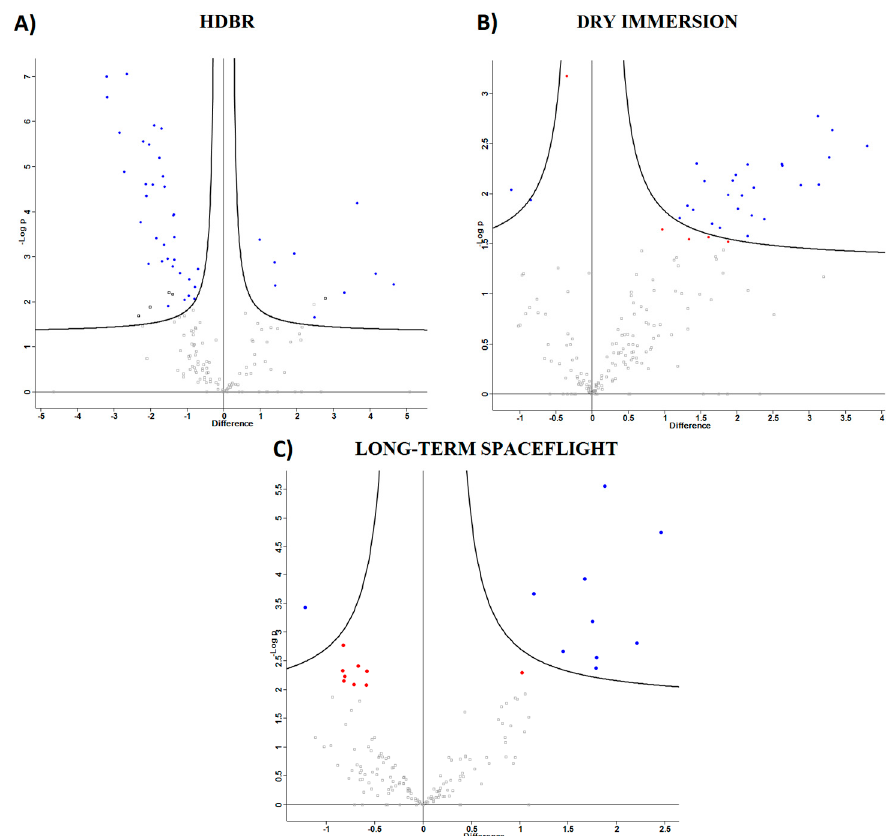
Figure 1. A volcano plot representing the results of the t -tests ( p -value > 0.01). The di ff erence for each protein was plotted against the –log10 of the p -value. ( A ) Proteins are significantly di ff erent from the background during head-down bed rest (HDBR). ( B ) Proteins significantly di ff ering from the background in the dry immersion experiment. ( C ) Proteins significantly changed at + 1 days after landing with respect to their background levels. Colours indicates volcano plot t -tests significance with a permutation-based false discovery rate (FDR) calculation for significantly changed proteins: blue—FDR < 0.05; red—FDR > 0.05.